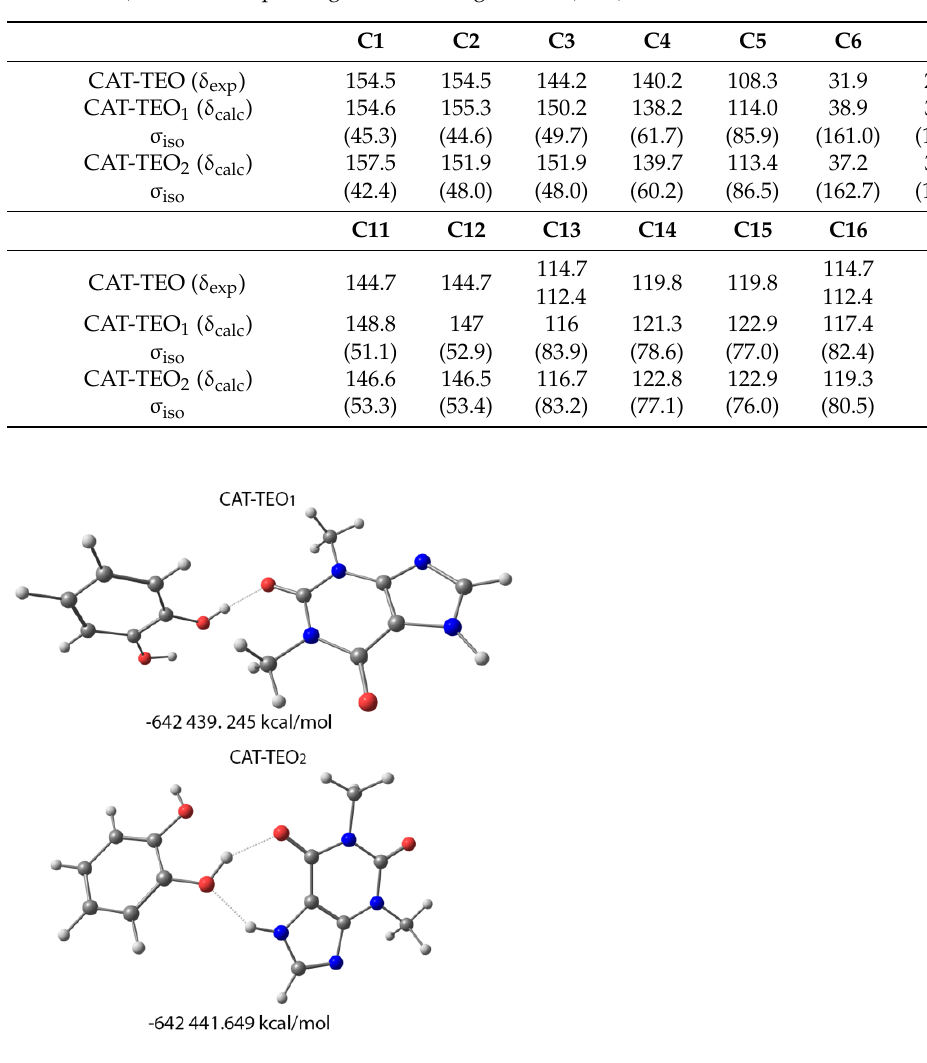
Table 3. Calculated ( δ calc) and experimental ( δ exp) CP/MAS solid state 13 C NMR chemical shifts (ppm) of TEO and CAT in the 1:1 anhydrous ground mixture, and calculated (root mean square error less than 4.0) GIAO isotropic magnetic shielding tensors ( σ iso).